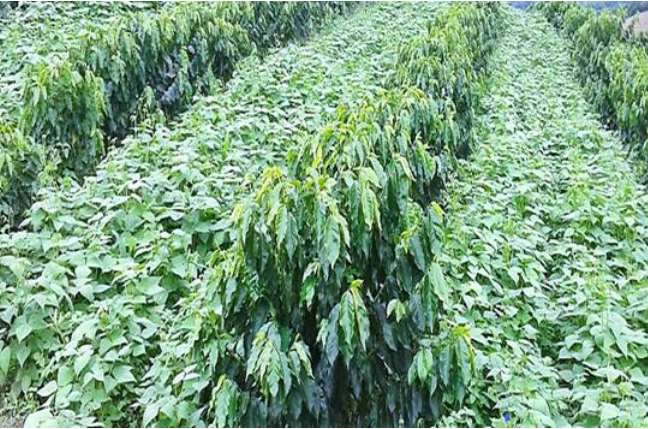
Figure 2. Coffee intercropped with common beans.